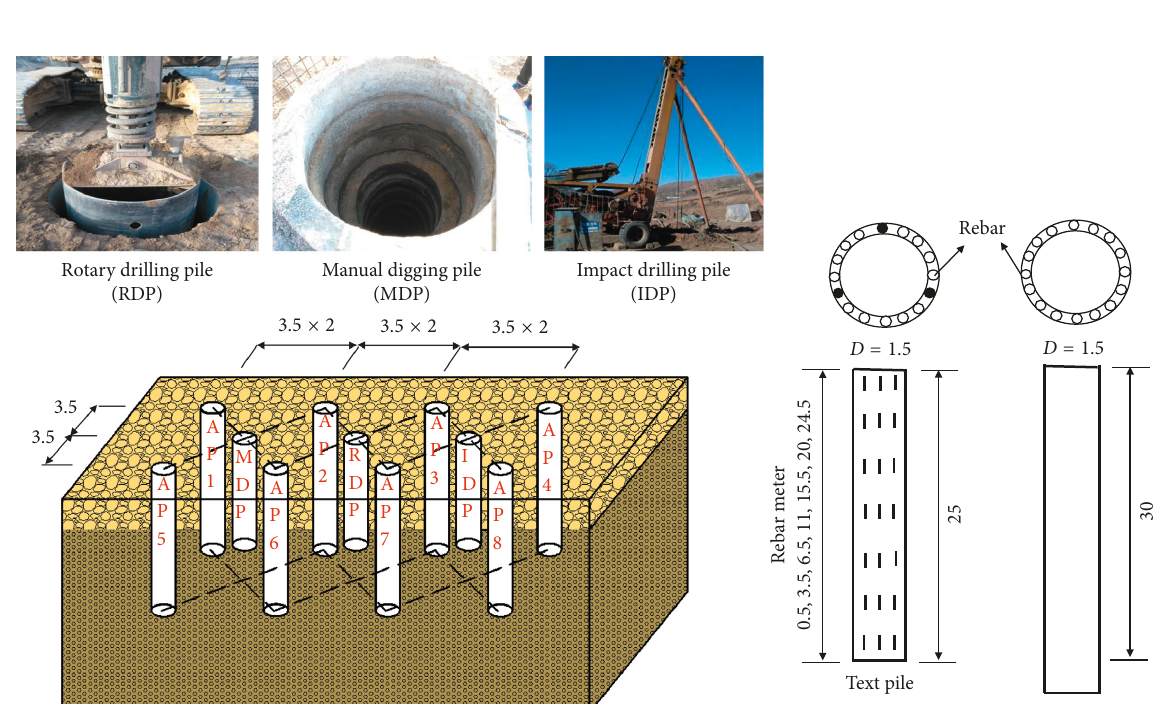
Figure 5: Layout of the test site (unit: